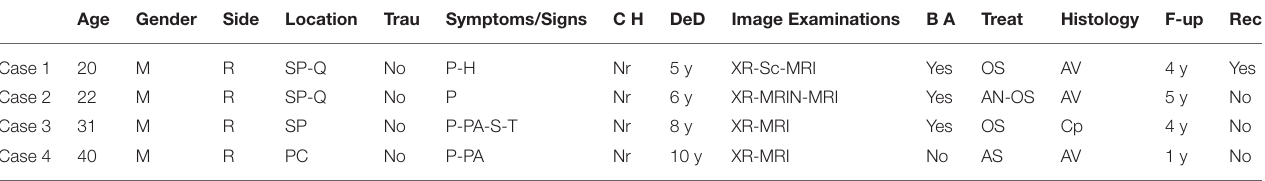
TABLE 1 | Clinical case demographics, tumor location, clinic, image examinations, treatment, histology, and follow-up. Age Gender Side Location Trau Symptoms/Signs C H DeD Image Examinations B A Treat Histology F-up